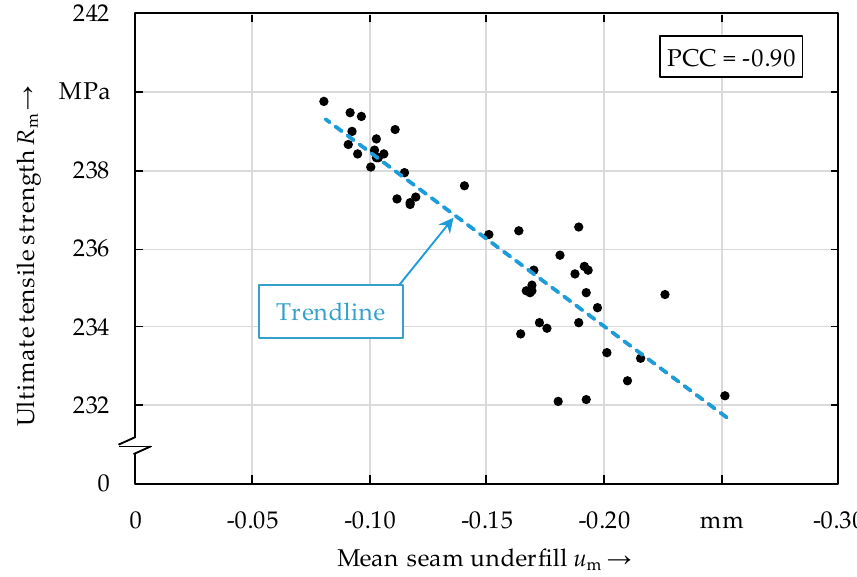
Figure 5. Ultimate tensile strength R m as a function of the mean seam underfill u m at a welding speed v s of 500 mm / min.